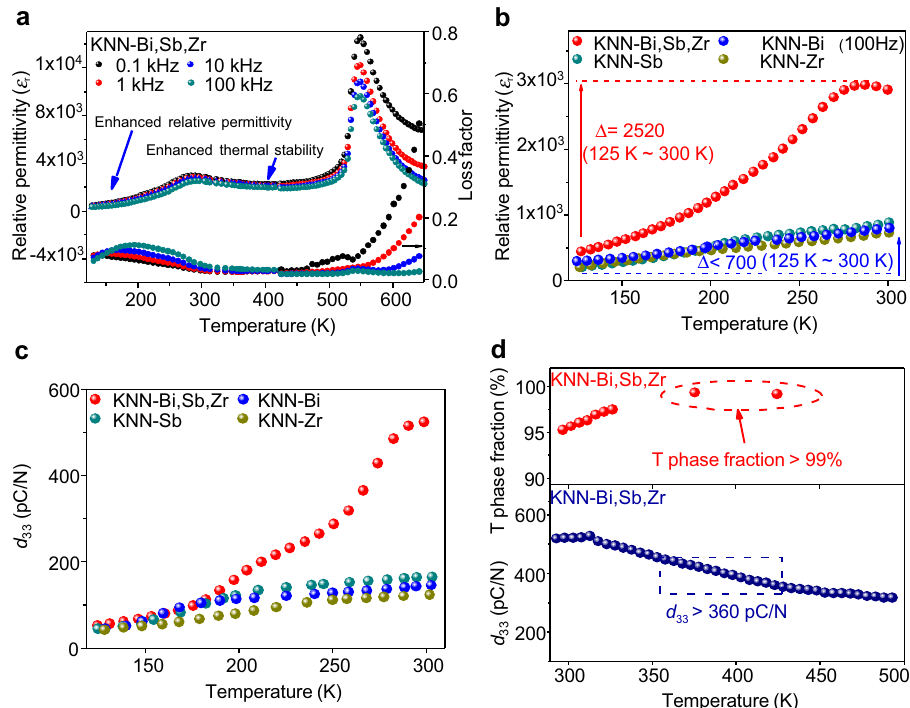
Fig. 2 The dielectric and piezoelectric property evolutions for multi-elements and single-element doped KNN ceramics. a The dielectric behaviour of KNN-Bi,Sb,Zr (multi-element doped KNN) ceramic over a temperature range of 130 – 700 K. b The dielectric and c piezoelectric properties of the multi- elements and single-element doped KNN ceramics over a temperature range of 120 – 300 K. d The temperature dependence of the tetragonal phase fraction and piezoelectric coef fi cients d 33 over a temperature range of 298 – 490 K for KNN-Bi,Sb,Zr